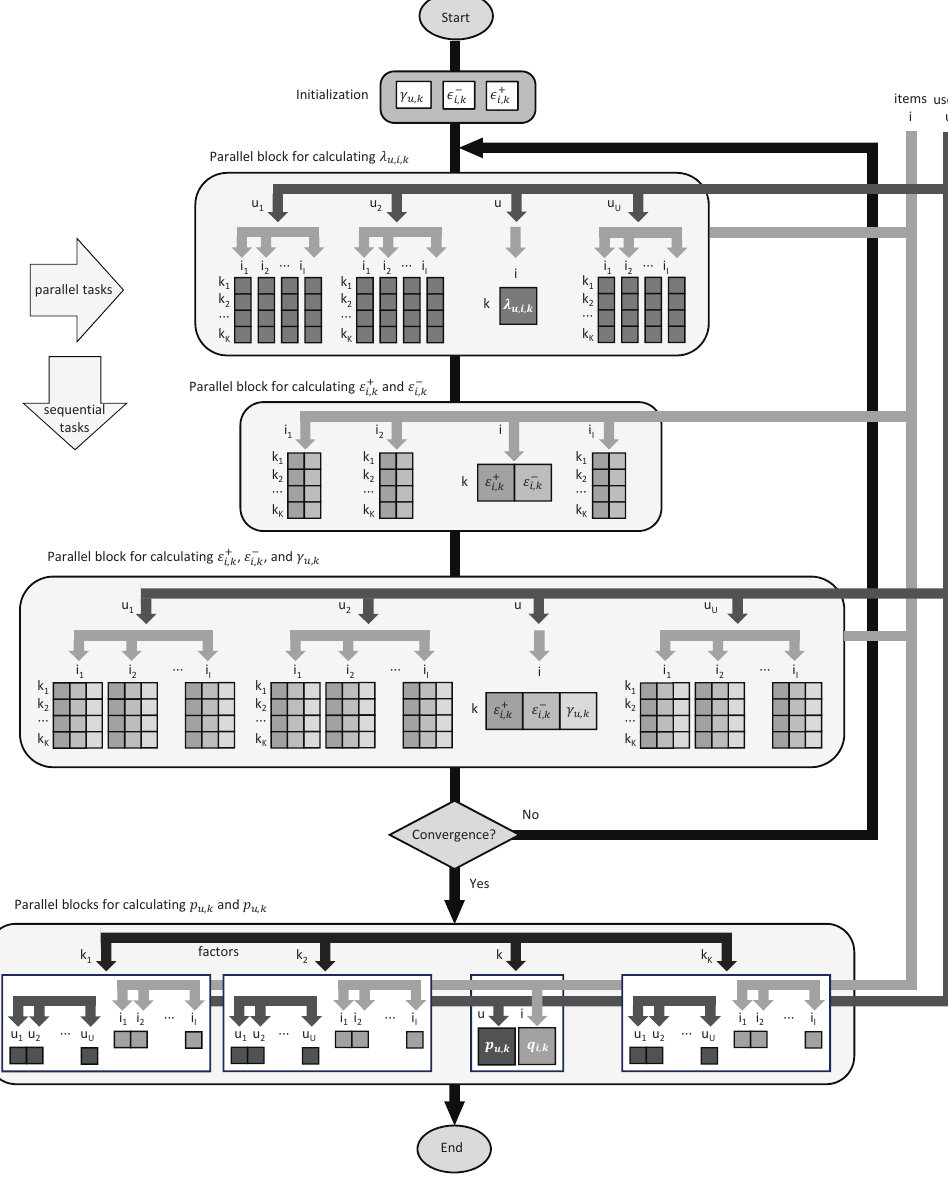
Figure 4. Strategy for parallelizing